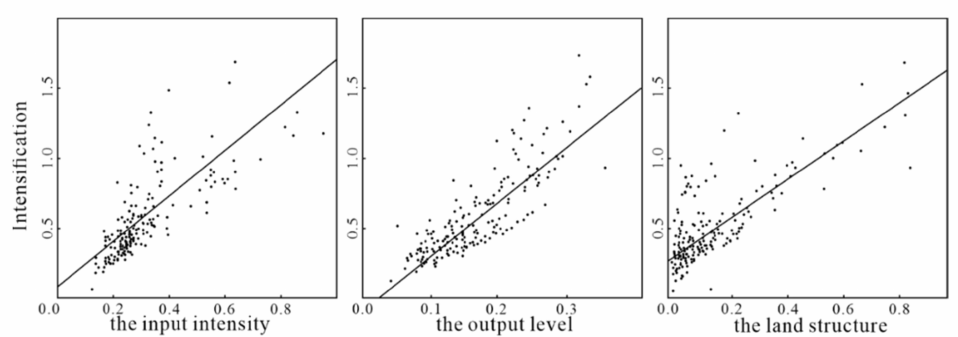
Figure 8. The left figure is the correlation between the intensification and the input intensity, the middle figure is the correlation between the intensification and the output level, and the right figure is the correlation between the intensification and the land structure.